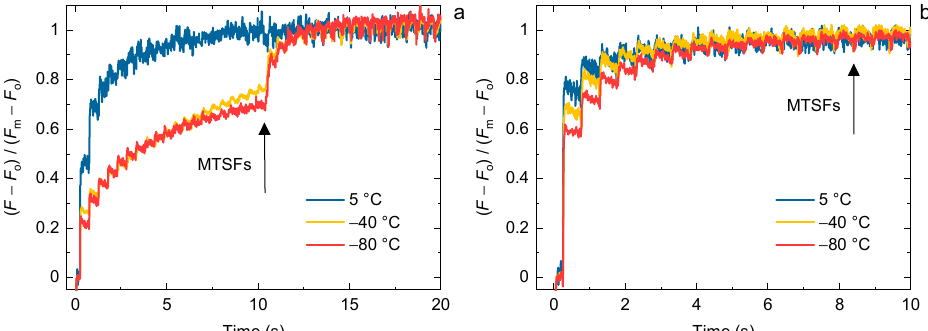
Figure 1. Temperature-dependent variations of the single-turnover saturating flash (STSF) induced Chl- a fluorescence transients of DCMU-treated PSII CC of T. vulcanus ( a ) and spinach TMs ( b ). The STSFs were applied 500 ms apart; at the end, blue laser flashes (multiple-turnover saturating flashes, MTSFs) with different lengths and amounts were fired to ensure the saturation. The measurements were performed using the PAM-101 based setup.